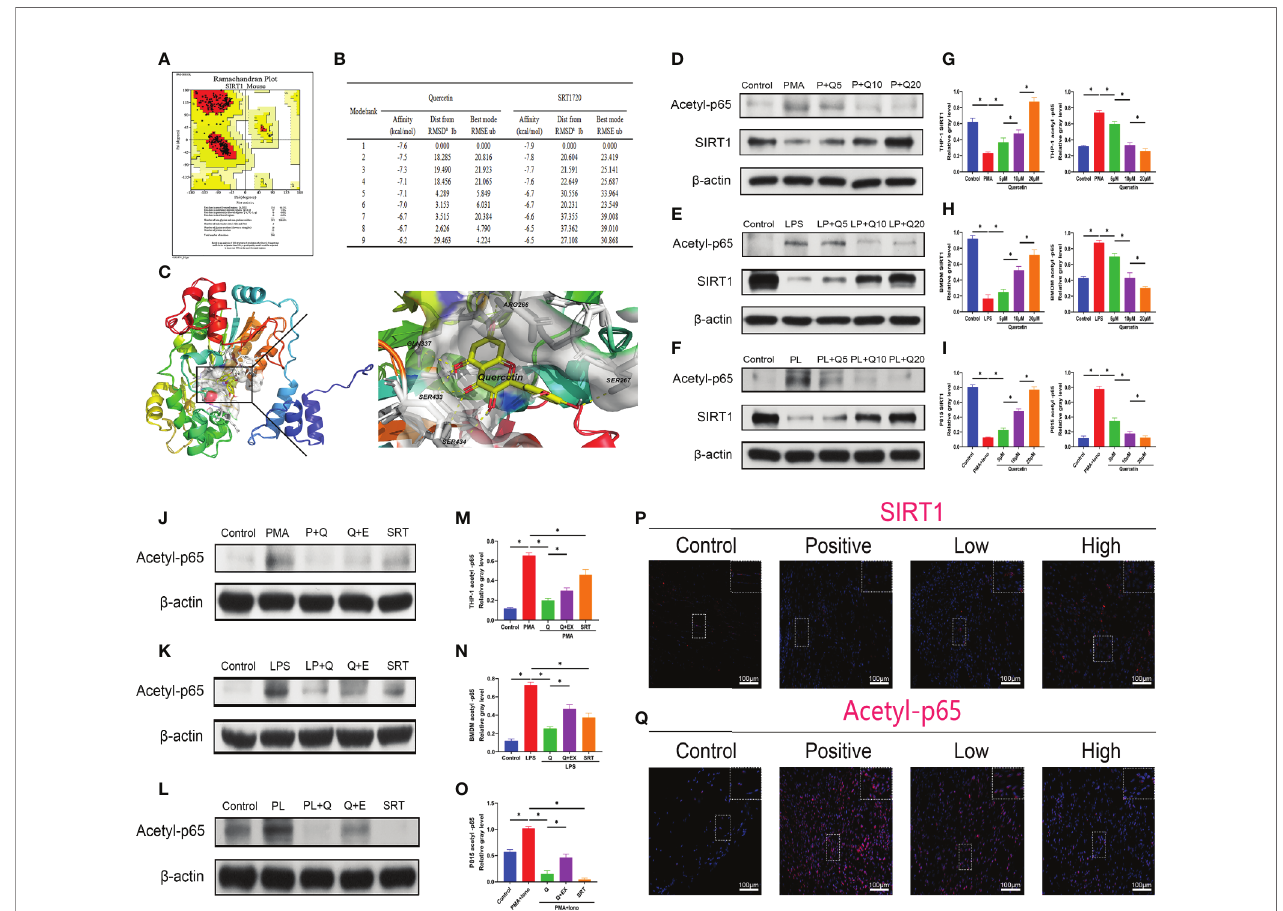
FIGURE 3 | Quercetin targets and modulates SIRT1 to reduce NF k B acetylation during immune response modulation. (A) Ramachandran plot for homology- modeled mouse SIRT1. The core area was colored red and involved 94.2% of the amino acid residues, while the allowed area was colored yellow and involved 5.8% of the amino acid residues. None of the amino acid residues were located in the generous (light yellow) or disallowed (white) areas. (B) Tables listing the nine top binding af fi nities of quercetin or SRT1720 to SIRT1. Af fi nity denotes binding energy, RMSD represents root-mean-square deviation and RMSE represents root-mean- square error. (C) Binding and interaction sites of quercetin with SIRT1 are shown. Cells were pretreated with 5 m M, 10 m M, or 20 m M quercetin for 1 h, and then incubated with respective stimulus for 1 h or 24 h. The effects of quercetin on SIRT1 and acetylated p65 expression in (D) THP-1, (E) BMDMs and (F) P815 cells during their activation were assessed by western blot. The relative level of SIRT1 and acetyl-p65 in (G) THP-1, (H) BMDMs and (I) P815 cells quanti fi ed using ImageJ and normalized to b -actin are shown. Cells were pretreated with 20 m M quercetin for 1 h, 10 m M EX527 and 1 m M SRT1720 HCI for 6 h and then incubated with respective stimulus for 1 h or 24 h. The effects of SIRT1 activation and inhibition on acetylated p65 expression in (J) THP-1, (K) BMDMs and (L) P815 cells during their activation were assessed by western blot. The relative level of acetylated p65 in (M) THP-1, (N) BMDMs and (O) P815 cells quanti fi ed using ImageJ and normalized to b -actin is shown. (P, Q) Immuno fl uorescence staining showing the expression of SIRT1 and acetylated p65 in the tissues 7 days after tenotomy. Original magni fi cation is 40x. Inserts are approximately 3.5x magni fi ed images of the boxed area. N=4/group. *P <